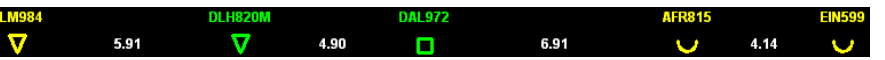
Figure 6. The CSVT. The symbols mark the positions of aircraft (triangle), ghosts (square) and TargetWindows (semicircle). The labels’ colours represent the aircraft’s weight classes (yellow: medium; green: heavy), and the white numbers between the labels indicate the current separation between